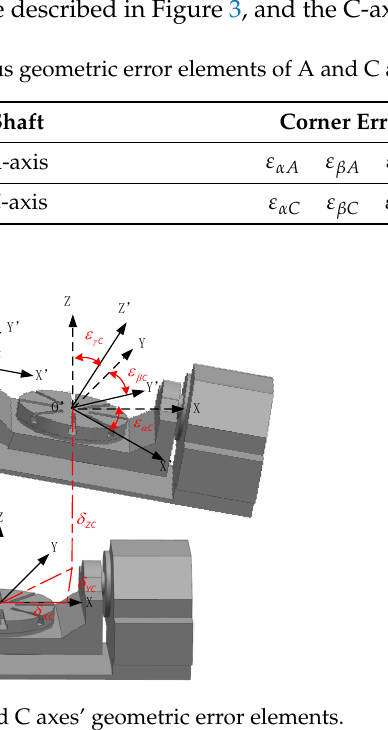
B -Bed body, 0 B -Tool. 7